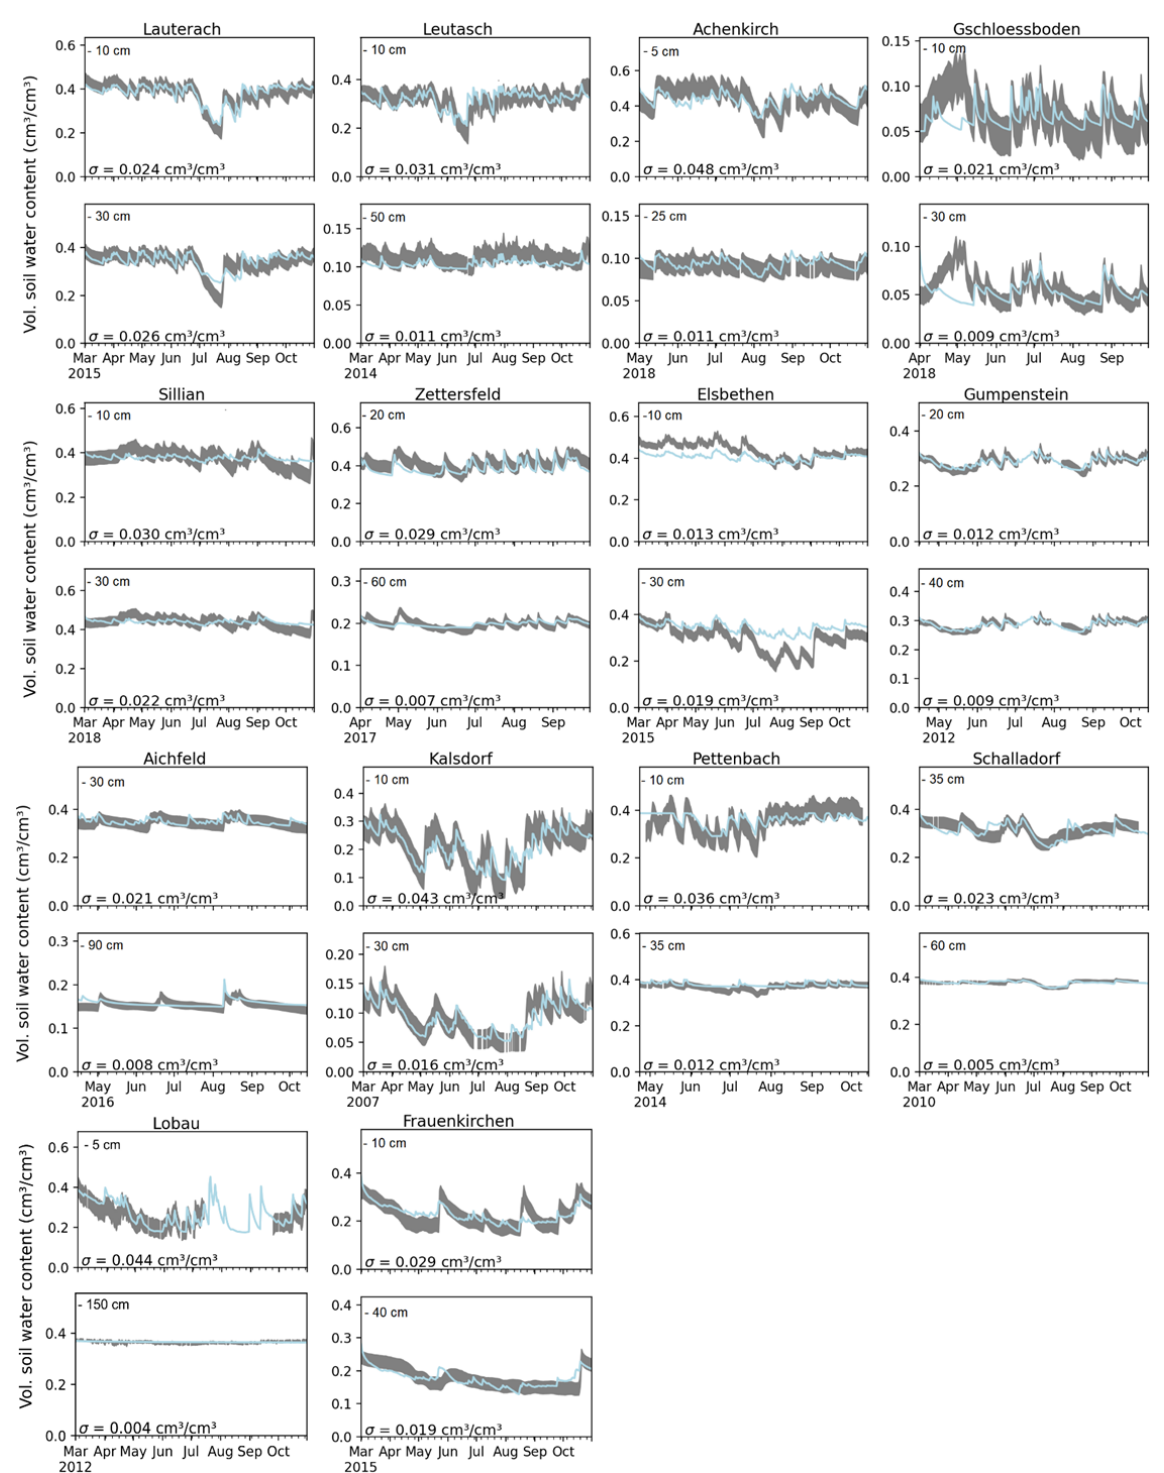
Figure A2. Calibration with soil water content measurements at all 14 sites: the gray bands show the measurement, including the area of the calibrated measurement error σ , and the blue lines show the prediction with the median parameter estimates for each measurement depth in the upper and lower soil